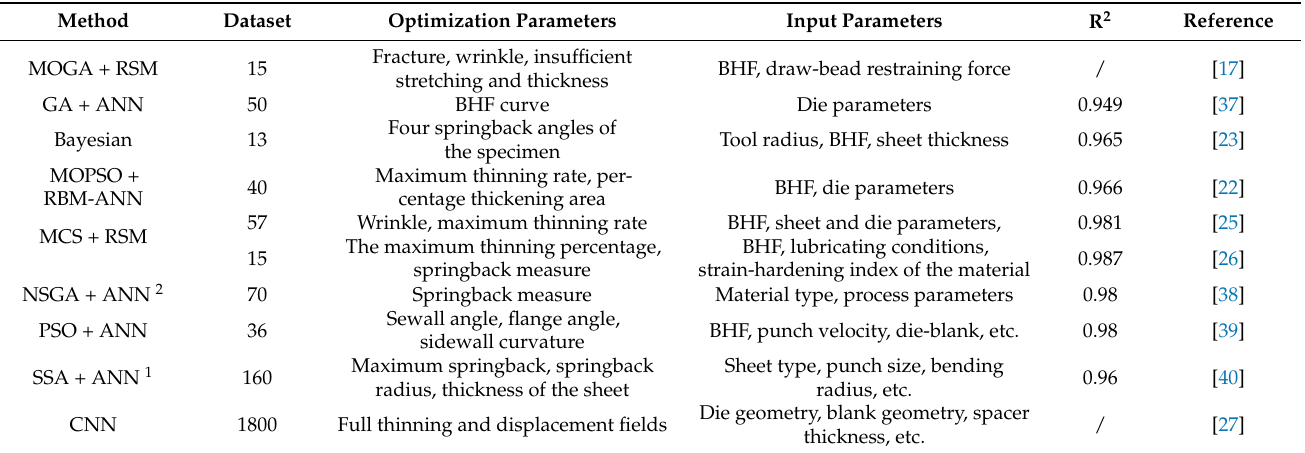
Table 1. A summary of intelligent optimization methods for